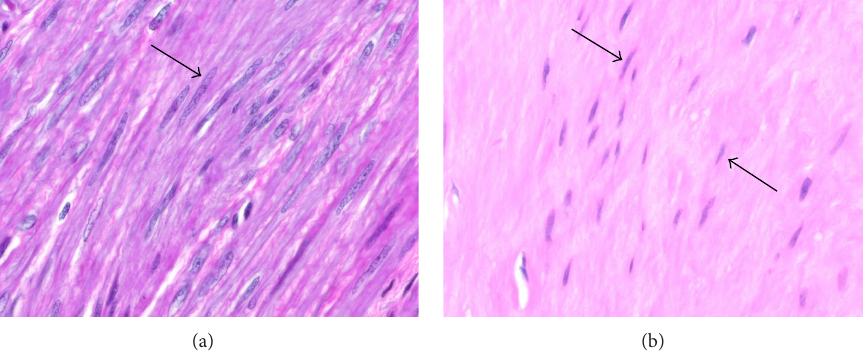
Figure 9: Cytoplasmic and nuclear atrophy. The eosinophilic cytoplasm of the fibroid myocytes in (b) is indistinct but appears diminished and less abundant than that of the myometrial myocytes in (a), and there is an obvious increase in the stroma that is separating the fibroid cells of this Phase 4 tumor. In addition, the nuclei of the myometrial cells in (a) are uniformly long and straight (arrow), while the fibroid nuclei in (b) exhibit variation in length and contour (arrows) and often appear to be shortened, suggestive of early nuclear shrinkage. Original objective magnification of both (a) and (b): 40x.